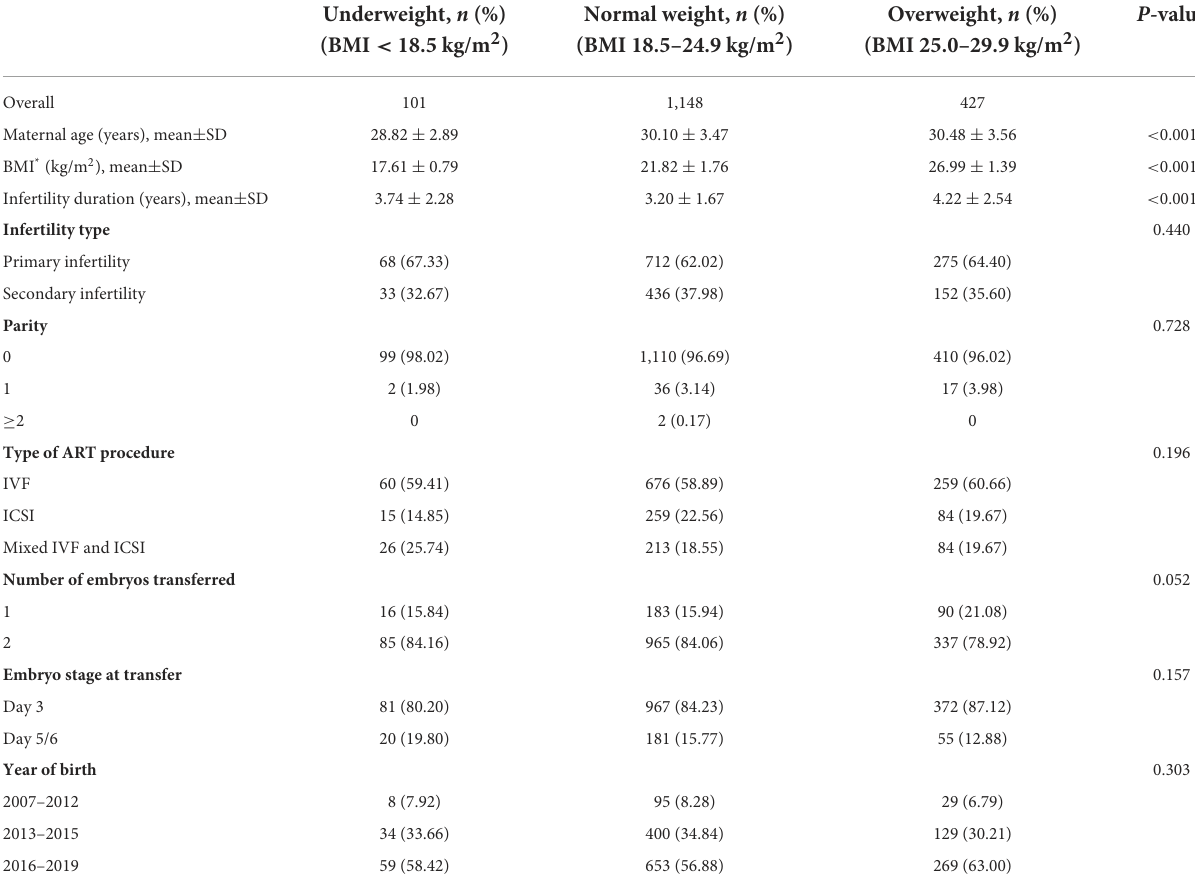
TABLE 1 Characteristics of the frozen-thawed embryo transfer cycles by maternal pre-pregnancy BMI among women with PCOS.